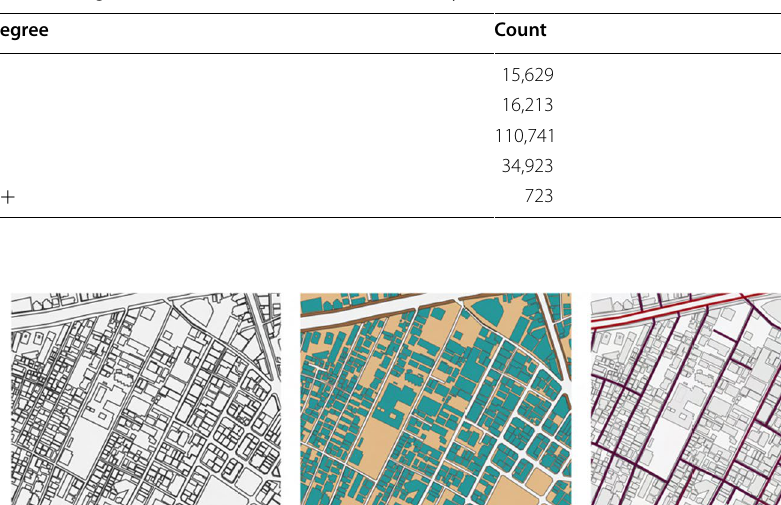
Table 1 Degree distribution of nodes in Central Tokyo